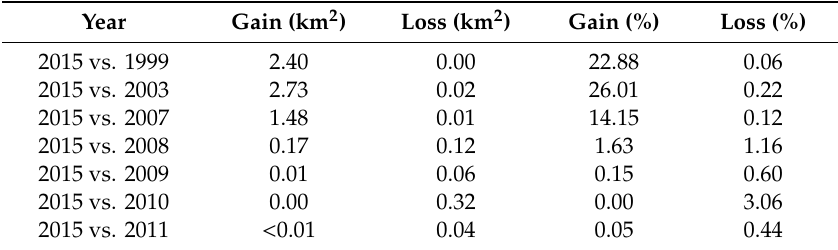
Table 2. Relative changes in vegetation cover for the time series 1999–2015, determined by a pixel-by-pixel comparison of the top of atmosphere (TOA) Landsat images from 2015 with those of the years 1999, 2003, 2007, and 2011, respectively. In the table are reported the relative increases ( gain ) and decreases ( loss ) in vegetation cover expressed as both surface (km 2 ) and percentage (%) compared to 2015.